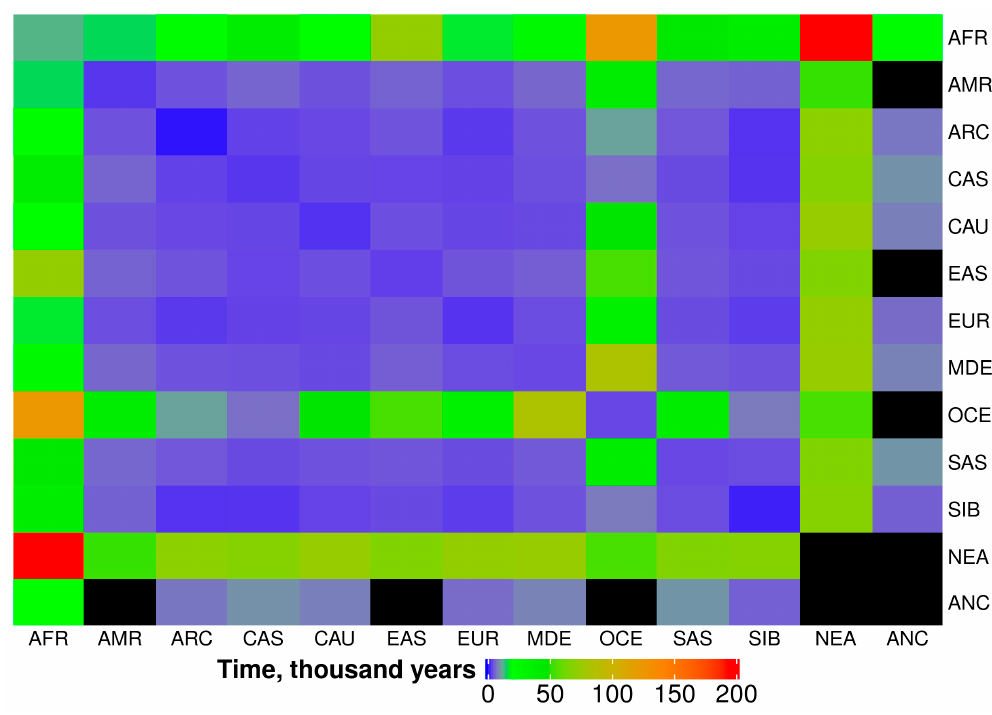
Figure 4. Heat map for estimated age of IBD fragments which are shared between populations from major geographical regions. Black color represents N/A data.